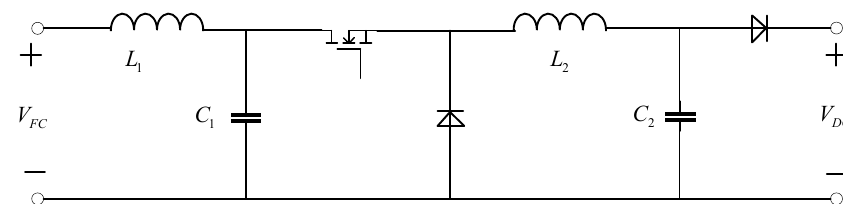
Figure 4. The topology of the unidirectional DC/DC transformer. The battery is connected to the DC bus through a bidirectional DC/DC transformer. The circuit structure of a typical bidirectional transformer is shown in Figure 5. The bidirectional transformer can discharge and charge the battery. The research status of FC + B is introduced below.